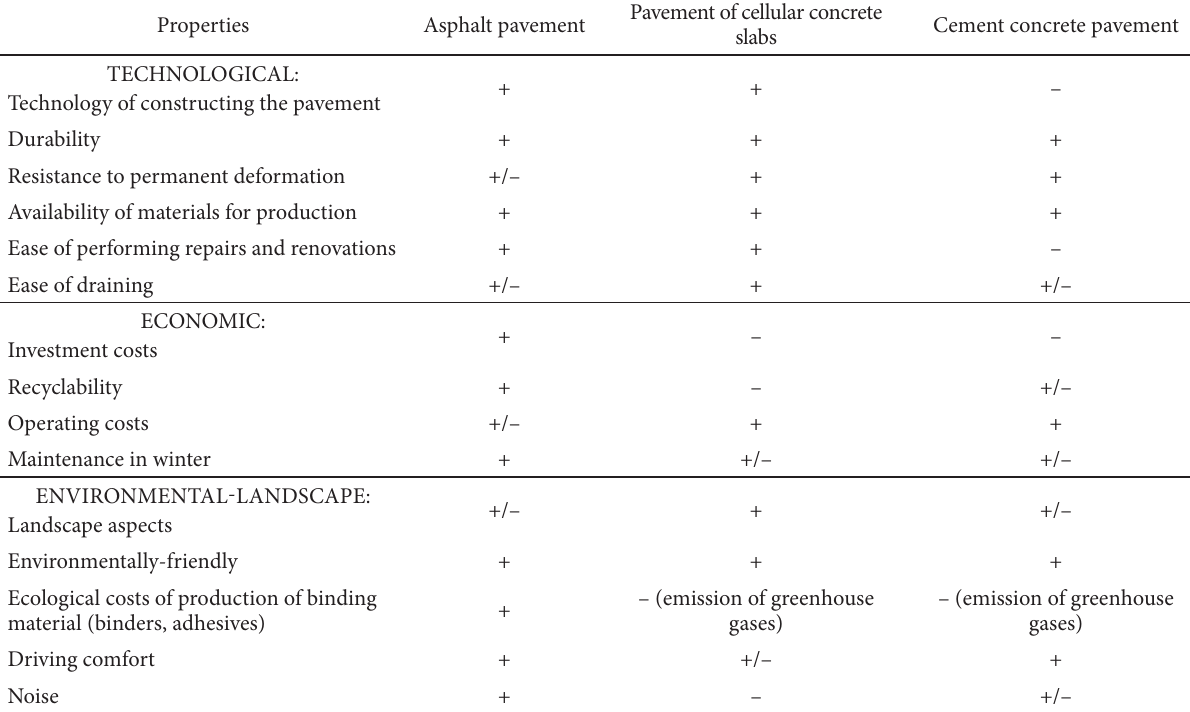
Table 1. Assessment of selected pavements of rural roads regarding technological, economic, and environmental-landscape factors